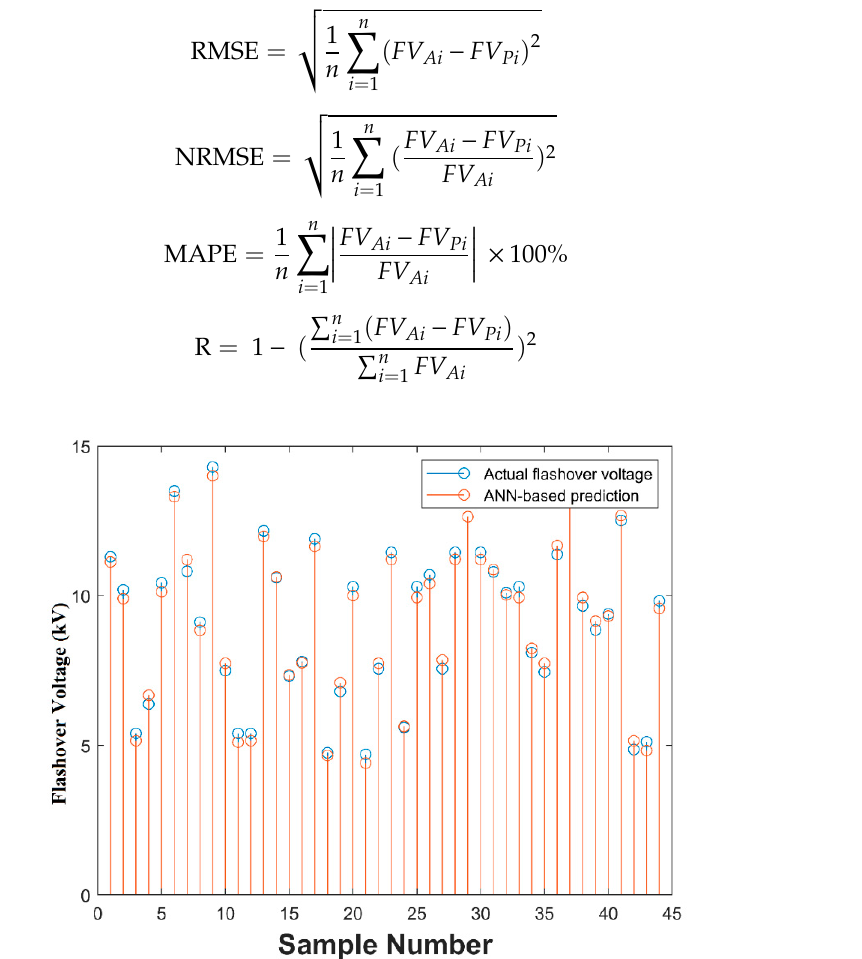
Figure 9. Comparison of the predicted and actual flashover voltage using the LM learning algorithm and 10 neurons in the hidden layer.